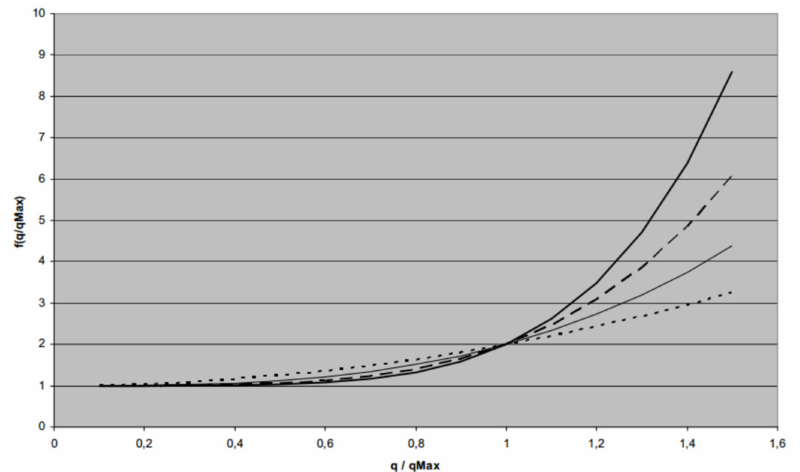
Figure 3. Example of volume–delay functions, source: